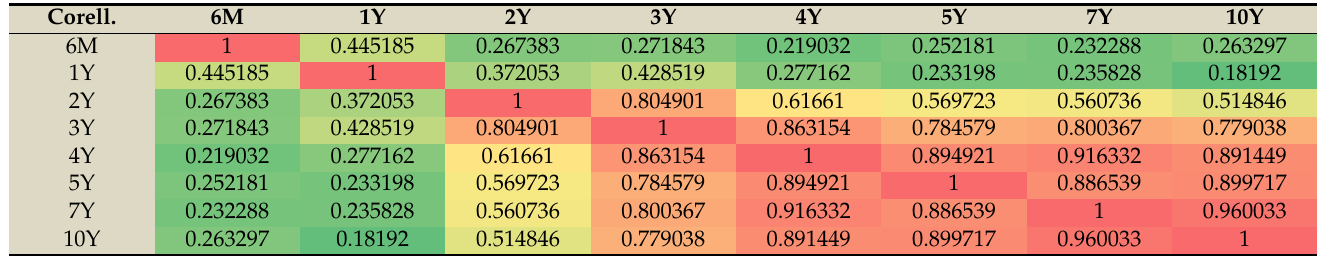
Table 2. Correlation matrix of Romanian weekly yield changes on 28 February 2020. Source: Bloomberg, own computation of the correlation matrix of yield changes.